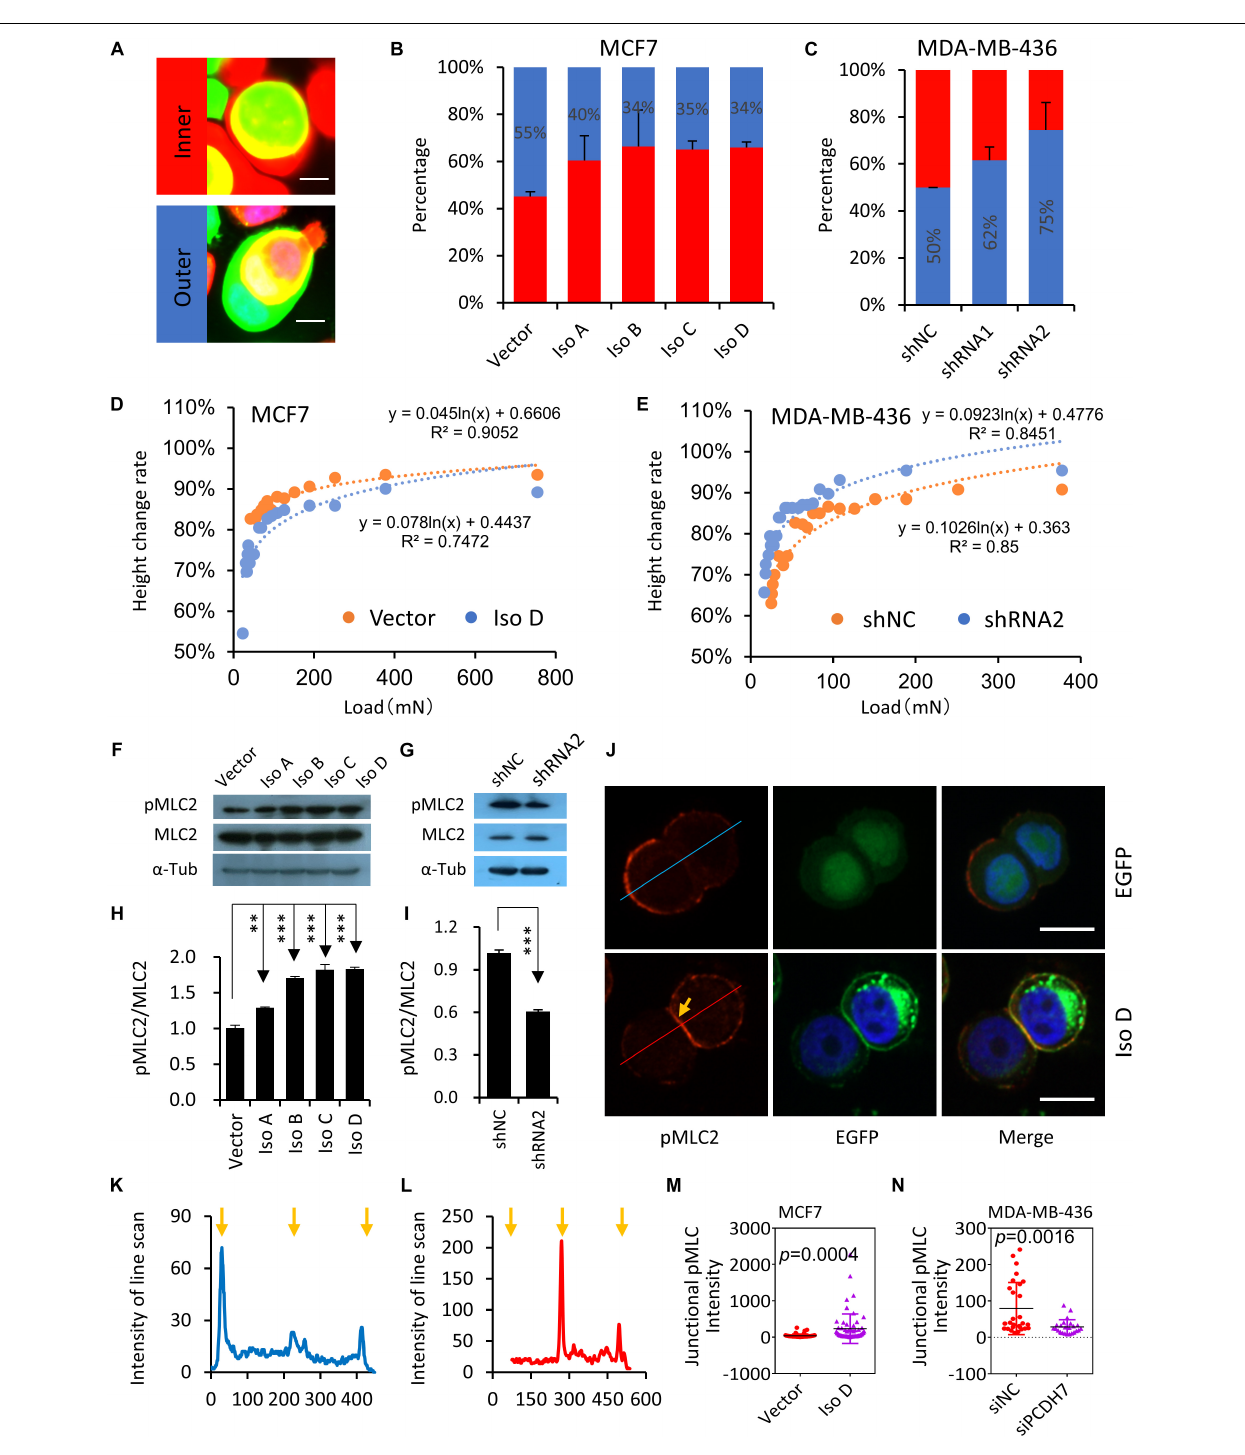
Frontiers in Cell and Developmental Biology |